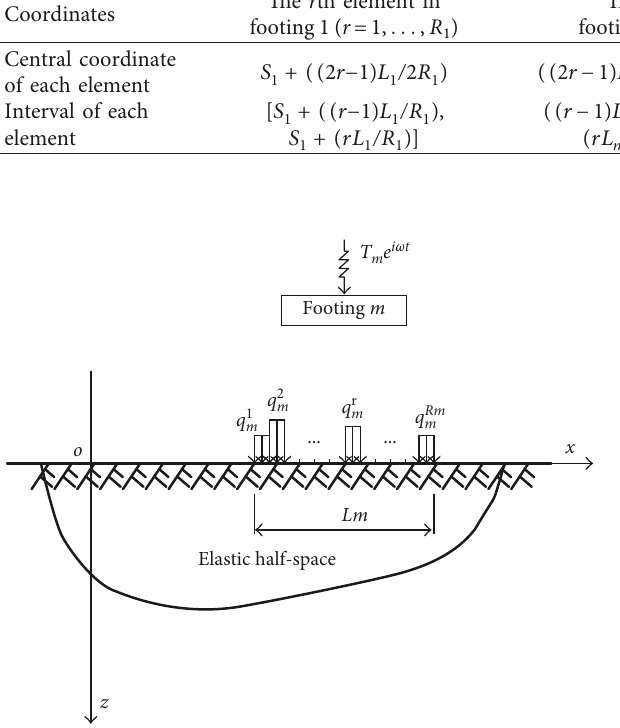
is the shear s (cid:31)